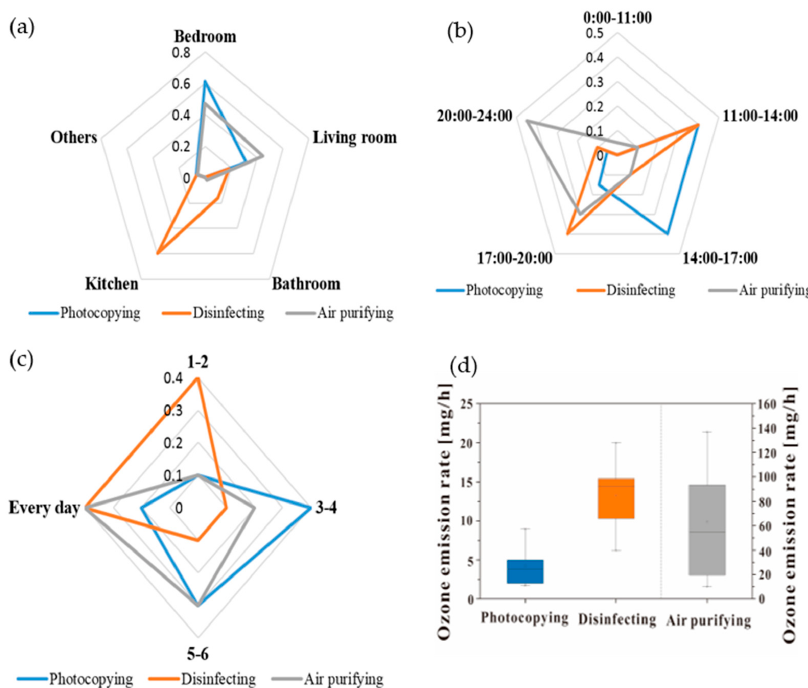
Figure 2. Questionnaire analysis. ( a ) The frequency of the devices in different rooms; ( b ) time period of use in a day; ( c ) frequency of use in a week; ( d ) ozone emission rate.